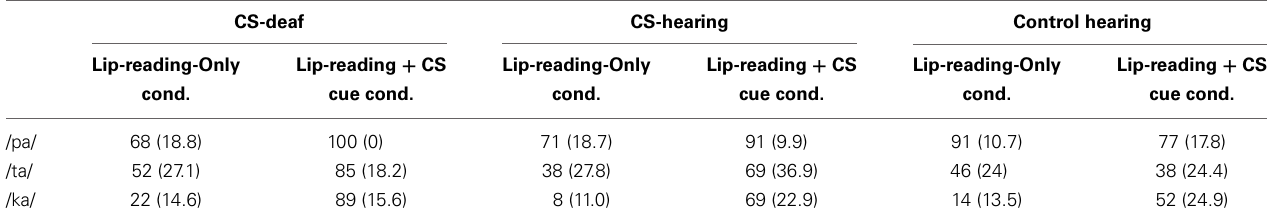
Table 6 | Mean percentages of correct responses for all groups in Audio + Lip-reading (LR) and Audio + LR + CS cue conditions. CS-deaf CS-hearing Control hearing